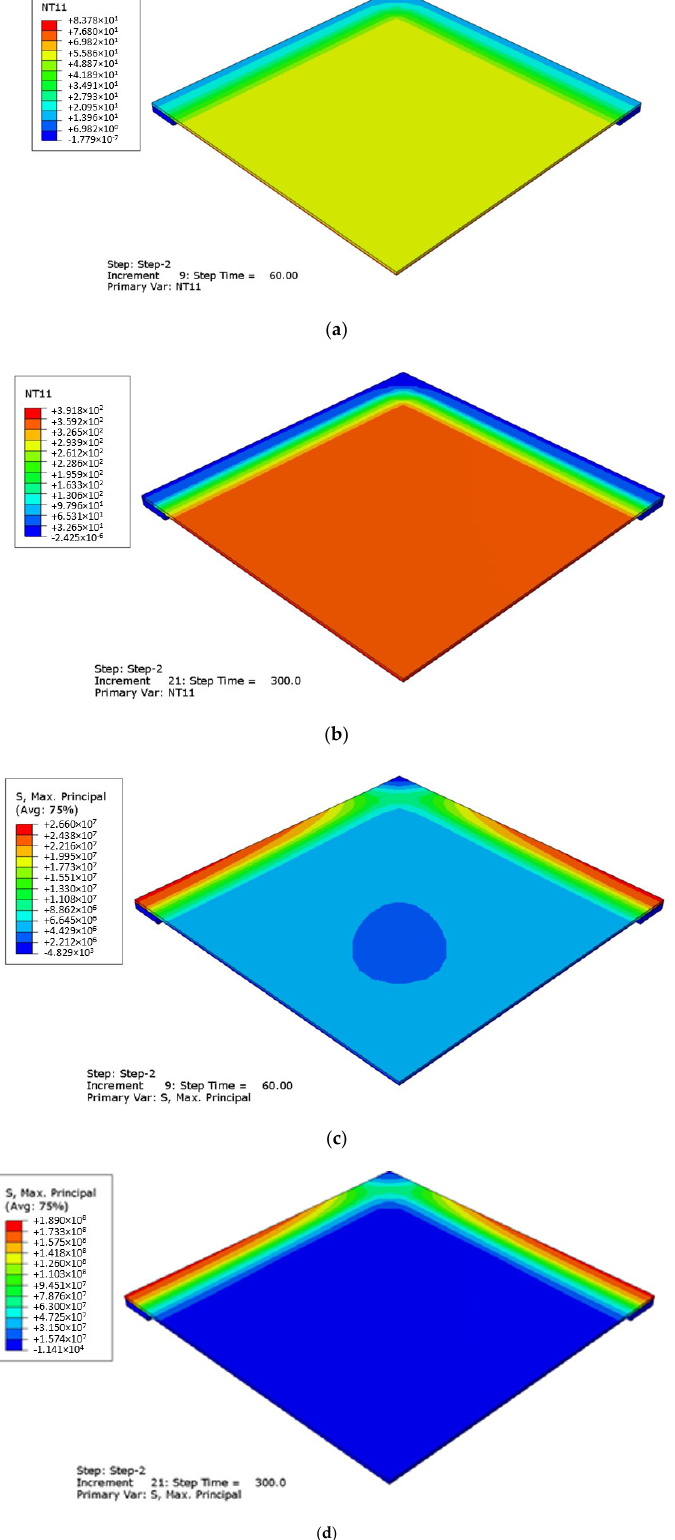
Figure 10. Evolution of ( a , b ) temperature and ( c , d ) stress peaks in glass due to thermal loading (ABAQUS/Standard), after 60 s ( a , c ) and 300 s ( b , d ) in fire conditions. Legend in ◦ C and